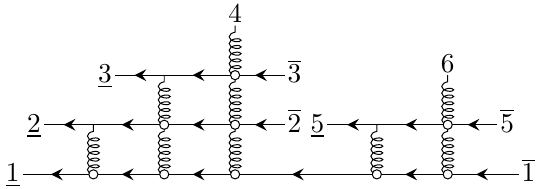
Figure 1 . Example of a ‘Mario world’ color diagram using JO’s diagrammatic notation. The diagram describes the color factor C (0) (1 ; 2 ; 3 ; 4 ; 3 ; 2 ; 5 ; 6 ; 5 ; 1). It corresponds to the primitive am- plitude given in